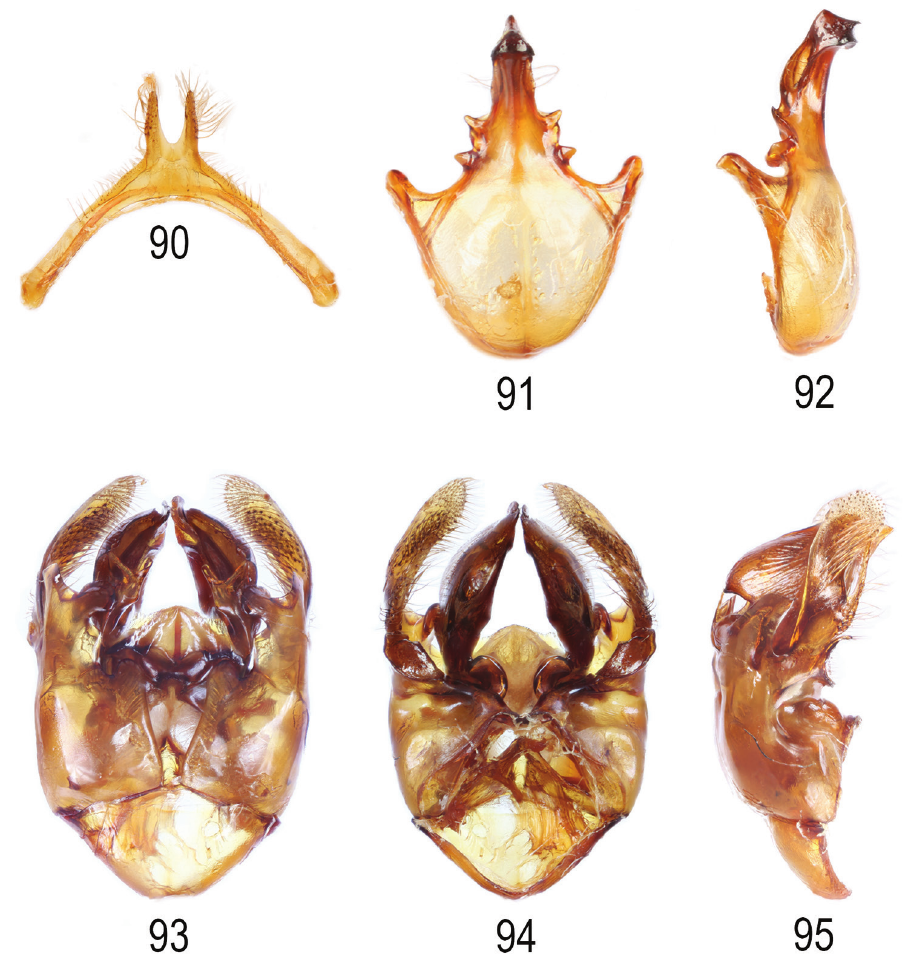
Figures 90–95. Male terminalia of E. barthelli (paratype. Mexico: Jalisco, Ajijic, KUNHM-ENT 0504535). 90 Seventh metasomal sternum in ventral view 91, 92 Eighth metasomal sternum in ventral and lateral views 93–95 Genital capsule in dorsal, ventral, and lateral